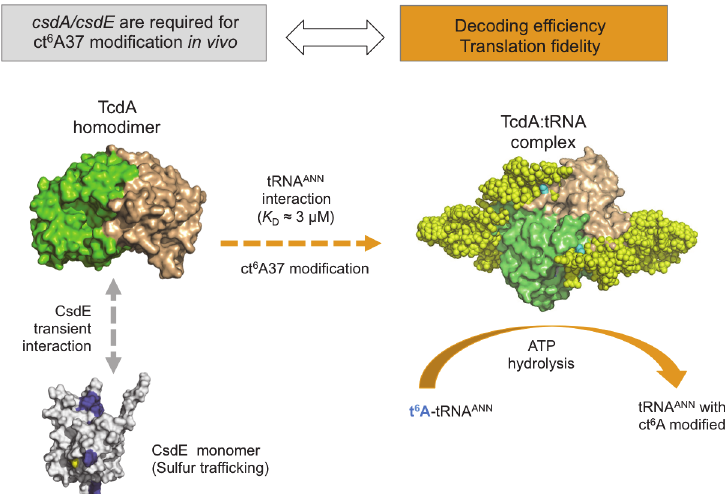
Fig 10. Interaction network for ct 6 A37-tRNA ANN modification. TcdA (surface representation, monomer chains in green and wheat colors) interacts transiently but specifically with the sulfur acceptor CsdE (in grey, with TcdA-binding surface patches in blue and Cys61 in yellow), linking with the CsdA-CsdE cysteine desulfurase system and sulfur trafficking, which are known to be required for ct 6 A37 synthesis in vivo [16]. The CsdE-TcdA transient interaction is represented by a grey double-headed arrow. TcdA interacts with tRNA ANN ( K D in the μ M range) in a 2:2 complex that harbors ATP-dependent t 6 A37 dehydratase activity. The ct 6 A37 hypermodification is important for decoding efficiency and translation